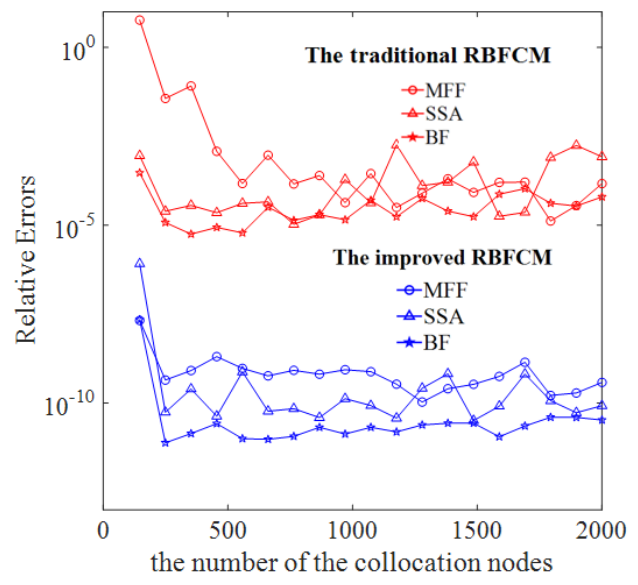
Figure 6. Relative errors with a different number of collocation nodes when R = 6.